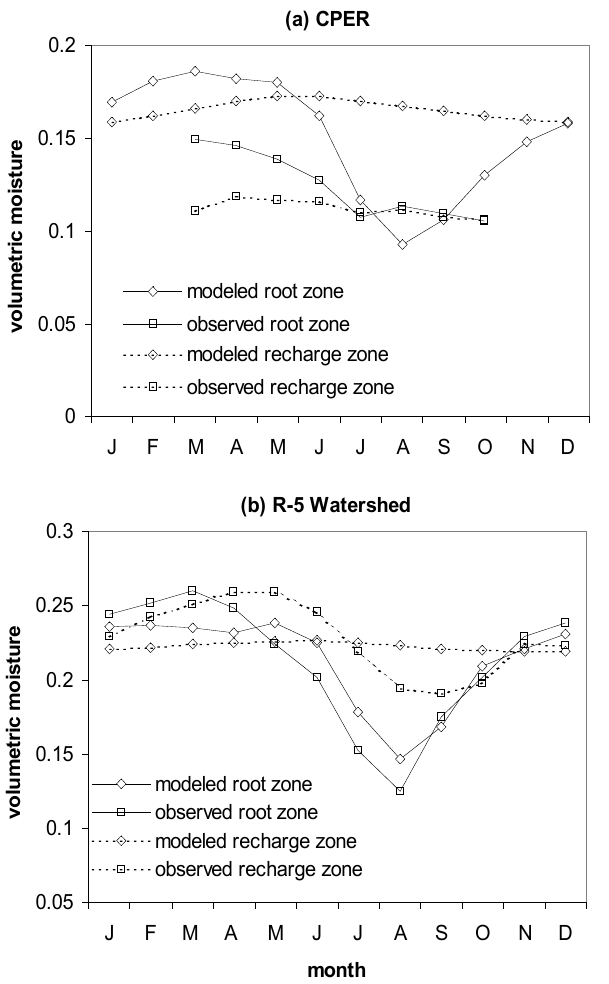
Fig. 9. Comparison of modeled and observed monthly mean soil moisture for: (a) the sandy-loam slope at the CPER, and (b) the R- 5 watershed. The observations for November–Febuary at the CPER are not plotted because of infrequent measurements (see Fig. 7a). The fact that observed spring recharge at the CPER is less than mod- eled is likely due to the first measurement being taken at a depth of 30cm. For a discussion of other discrepancies between modeled and observed soil moisture see Sect. 7.